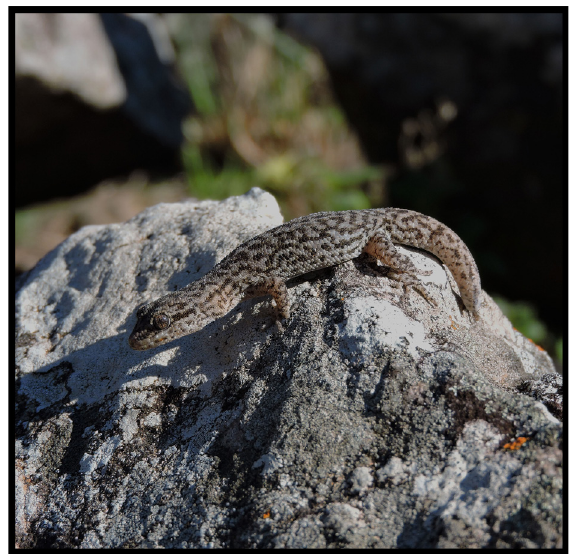
Figure 1. Adult of Homonota taragui.